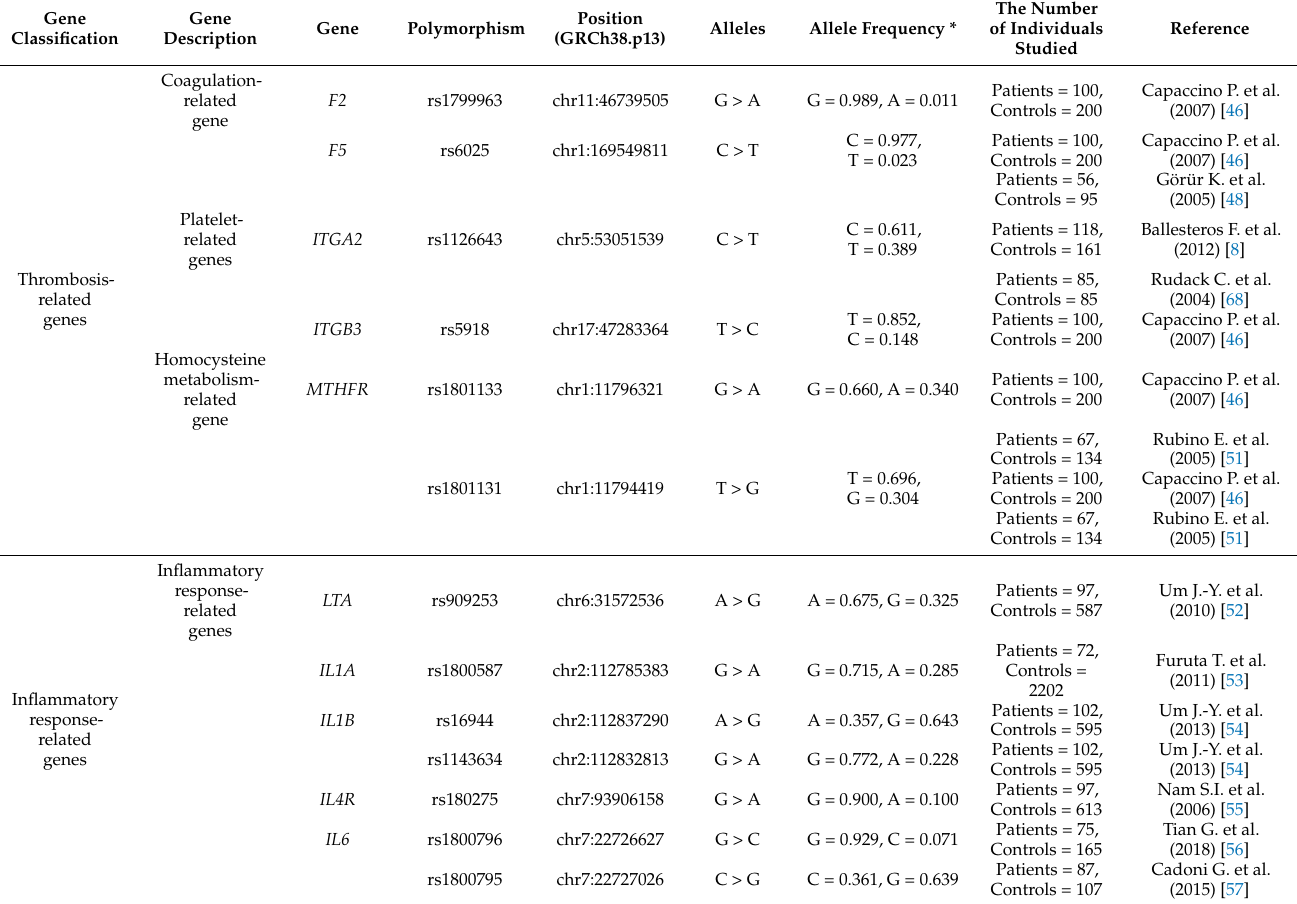
Table 1. Genetic polymorphisms associated with susceptibility to sudden sensorineural hearing